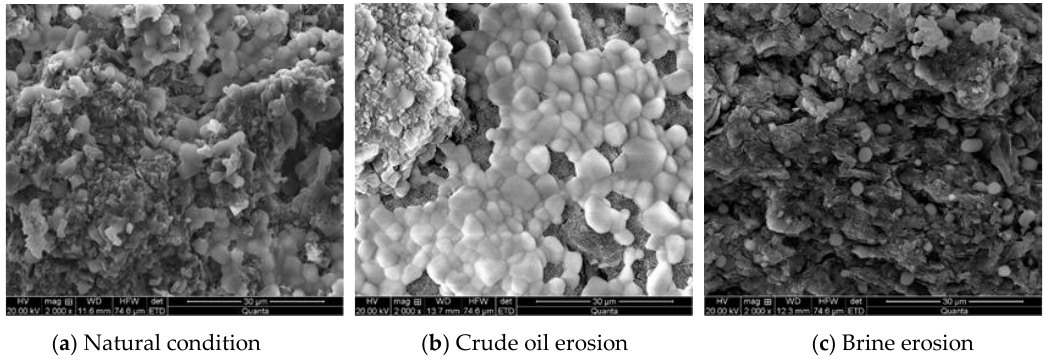
Figure 15. The SEM result of the interlayer samples under different immersion conditions.